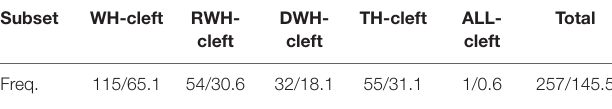
TABLE 2 | Subsets of pseudo-clefts (raw frequency/per 1,000,000 words). Subset WH-cleft RWH- cleft